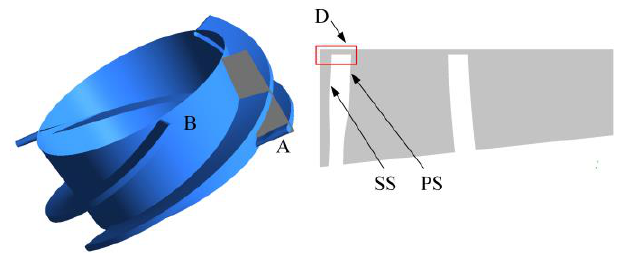
Figure 10. Schematic of the axial plane.